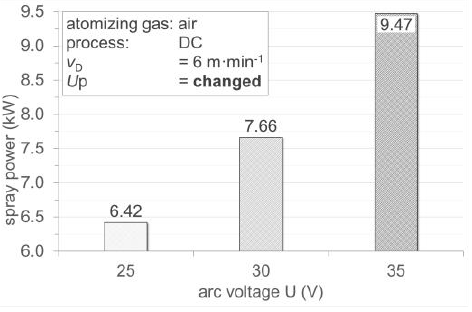
Figure 9. Comparison of the spray power as a function of the arc voltage with direct current.